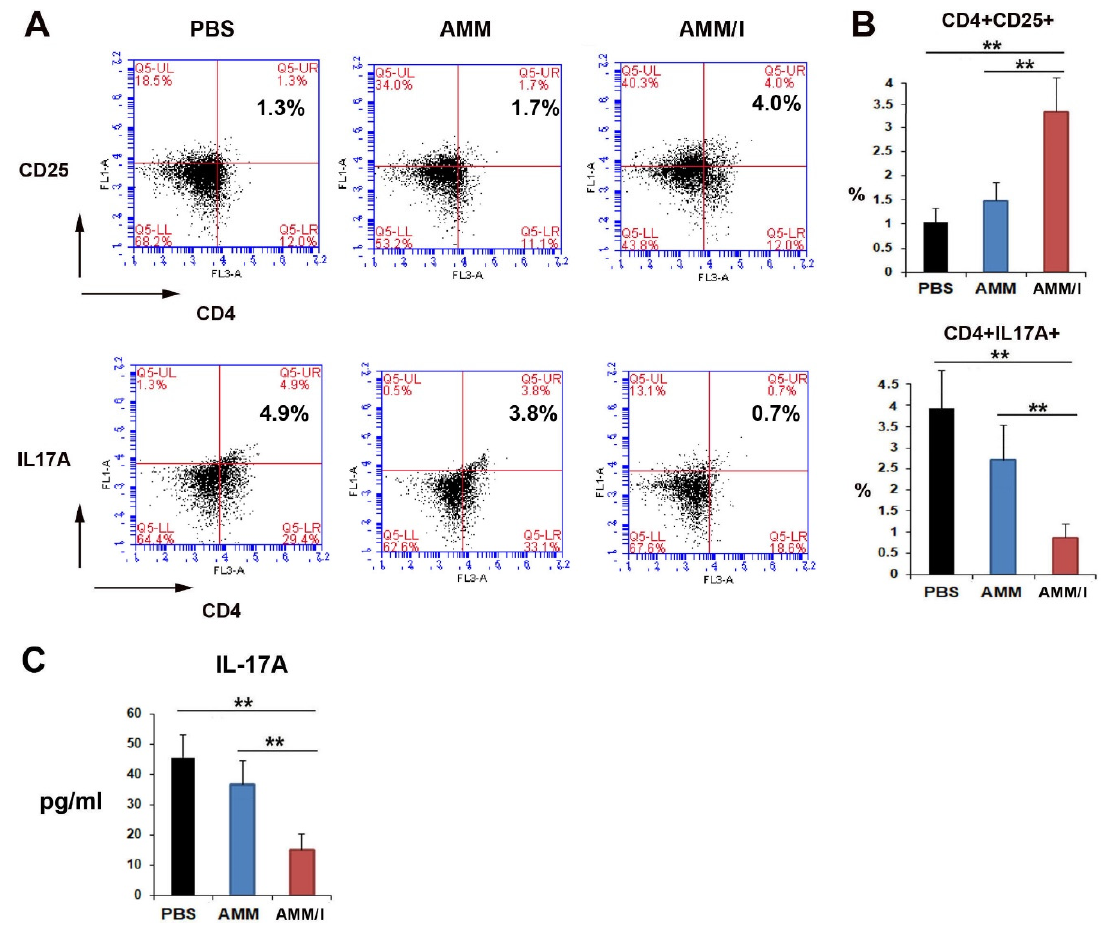
Figure 3. AMM/I transplantation influences the populations of regulatory T cells (Tregs) and helper T (Th)-17 cells in collagen-induced arthritis (CIA) mice. ( A ) Representative figure of flow cytometry data for the identification of Tregs and Th17 cells. ( B ) Quantitative data for Tregs and Th17 cells were measured using CIA mouse blood samples two weeks after the injection of cells (n = 5 each; * p < 0.05, ** p < 0.01). ( C ) The concentration of IL-17A in CIA mice two weeks after cells injection (n = 5 each; ** p < 0.01).